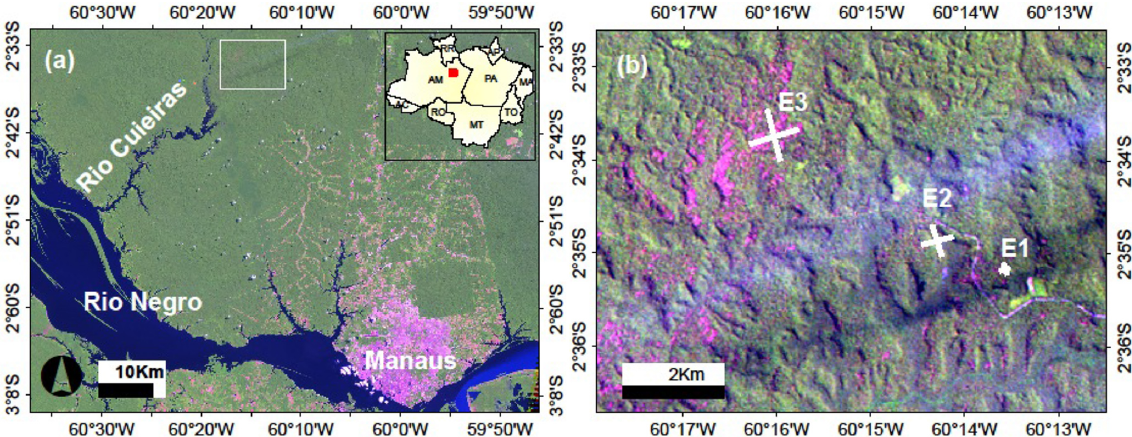
Figure 1. Study area (white inset) on the left side of the Rio Cuieiras, Amazonas, Brazil (a) . Sampled transects (white inlet) set along wind- disturbed terra firme forest at the Estação Experimental de Silvicultura Tropical (EEST/INPA) and a contiguous forest (SUFRAMA; b ). The reddish color in (b) indicates the high middle-infrared reflectance (dead wood and litter) of wind-disturbed areas. Image: RGB composition (bands 3, 4, and 5) from Landsat 5 TM (p231, r062, from 29 July 2005). Image source: